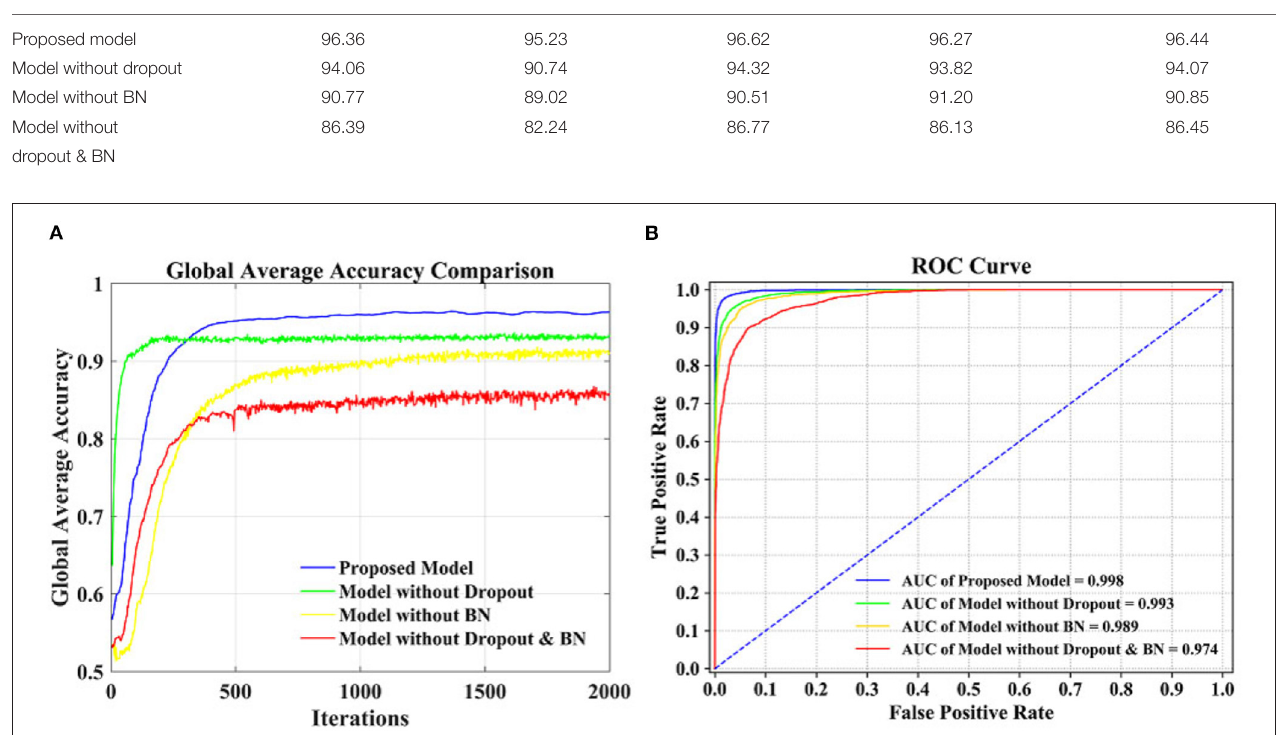
FIGURE 5 | Performance comparison of different models. (A) Accuracy comparison. (B) ROC curve